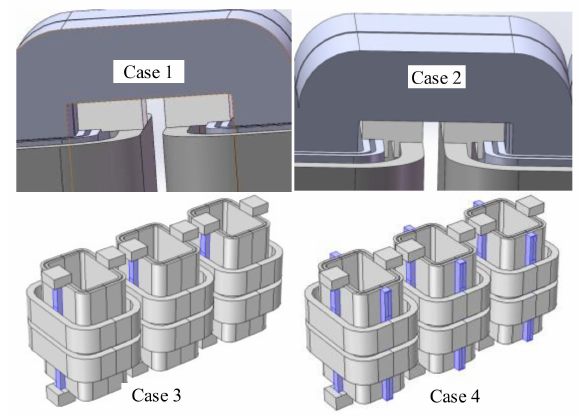
Figure 24. Different methods of vibration reduction in